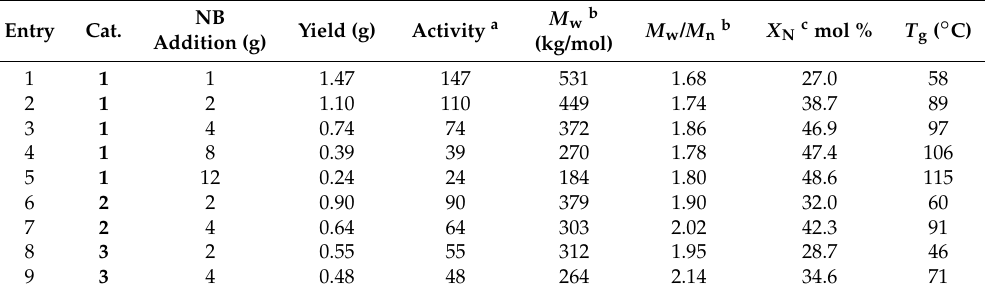
Table 2. Copolymerizations of ethylene and norbornene with 1–3 /MAO.